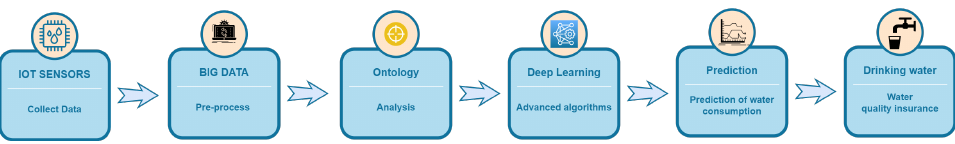
Figure 6. Decision making flow in water infrastructure.